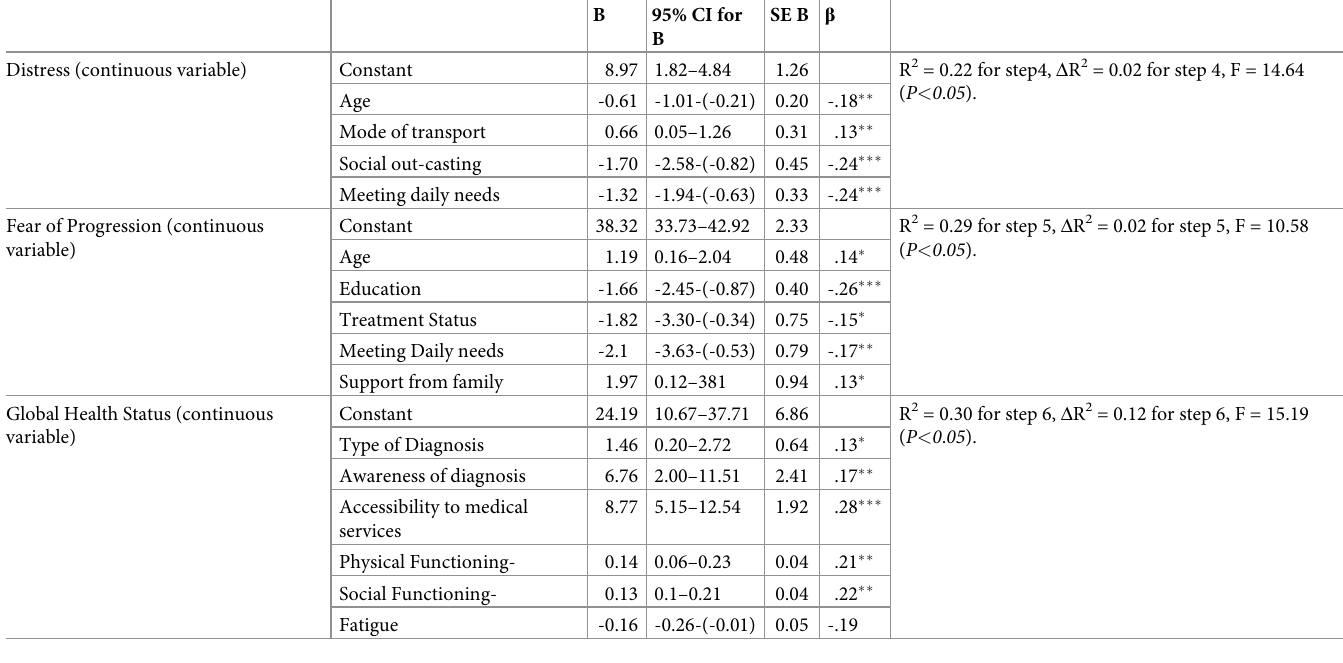
Table 5. Multiple regression analyses of distress, fear of progression and global health status.